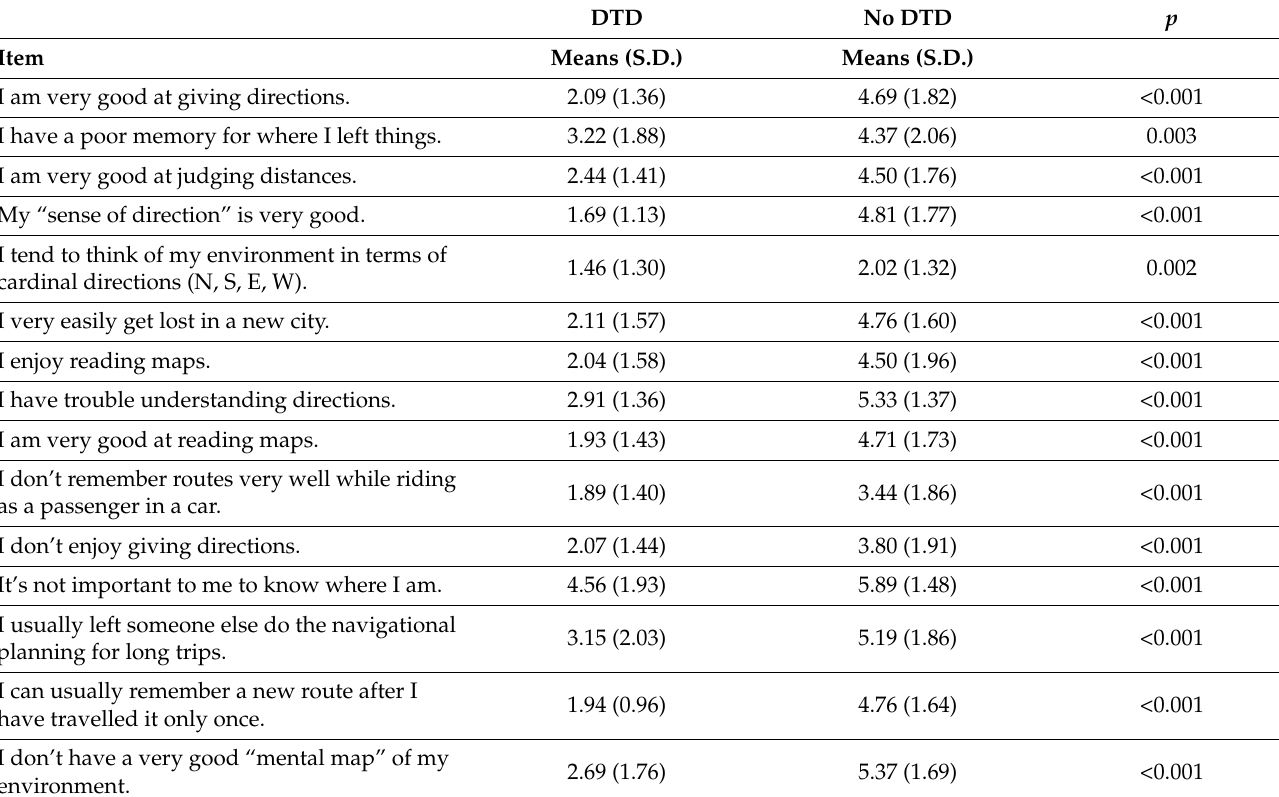
Table 2. Means and S.D. of each item of SBSOD